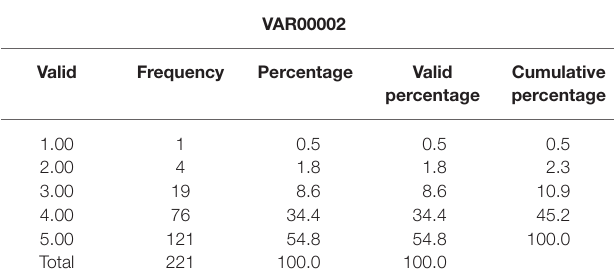
TABLE 2 | The way the activity was presented and worked on has motivated me to know more about the use of comics as a resource for teaching and learning about